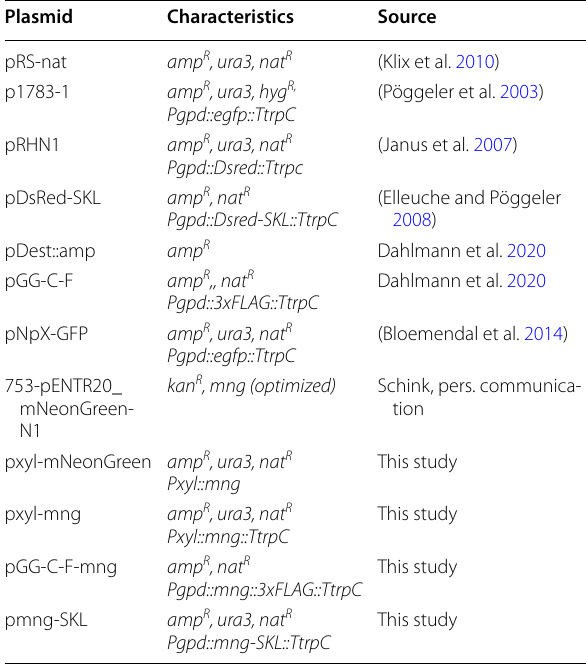
Table 2 List of plasmids used in this